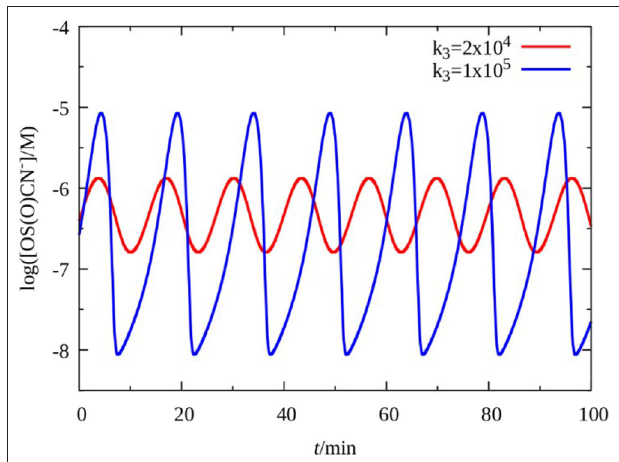
FIGURE 7 | Simulated oscillations in the five variables model of the H 2 O 2 –SCN − –Cu(II) reaction as a function of parameter k 3 .